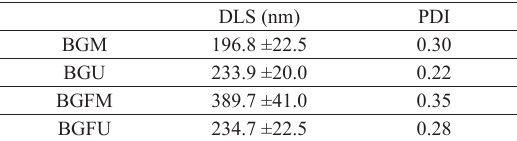
Table 2. Particle size obtained by DLS